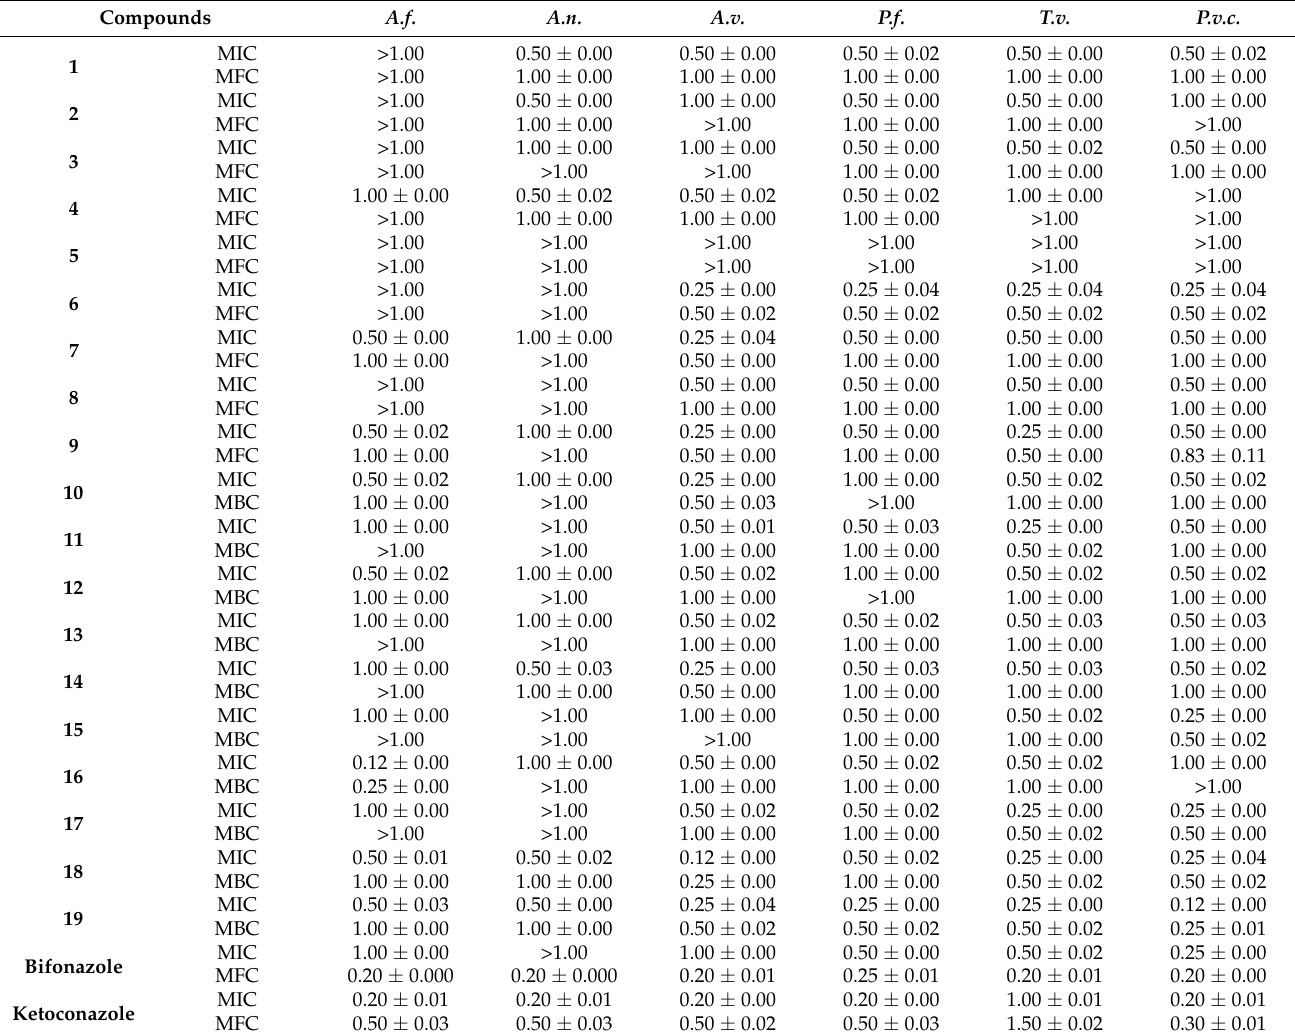
Table 6. Antifungal activity of tested compounds (MIC and MBC in